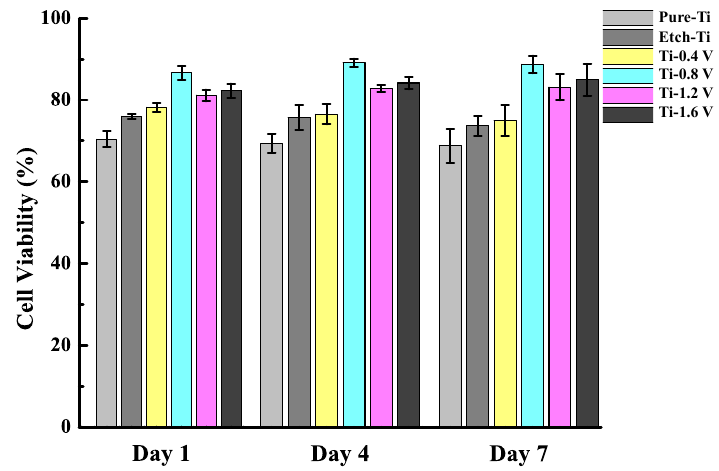
Figure 4. Contact angles on different samples: ( a ) pure Ti, ( b ) etched Ti, and deposited HAp ( c ) Ti-0.4 V, ( d ) Ti-0.8 V, ( e ) Ti-1.2 V, and ( f ) Ti-1.6 V.